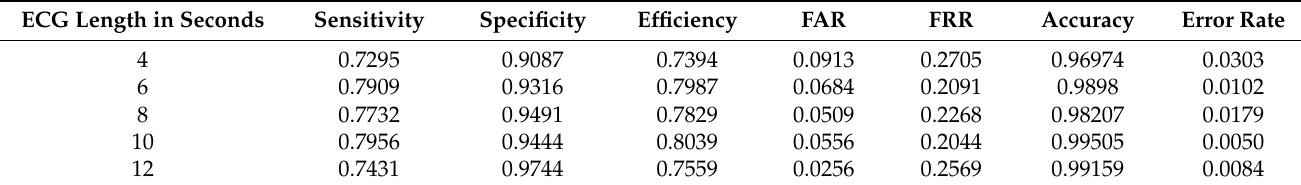
Table 4. The proposed method experimental results with the modified FFT method.